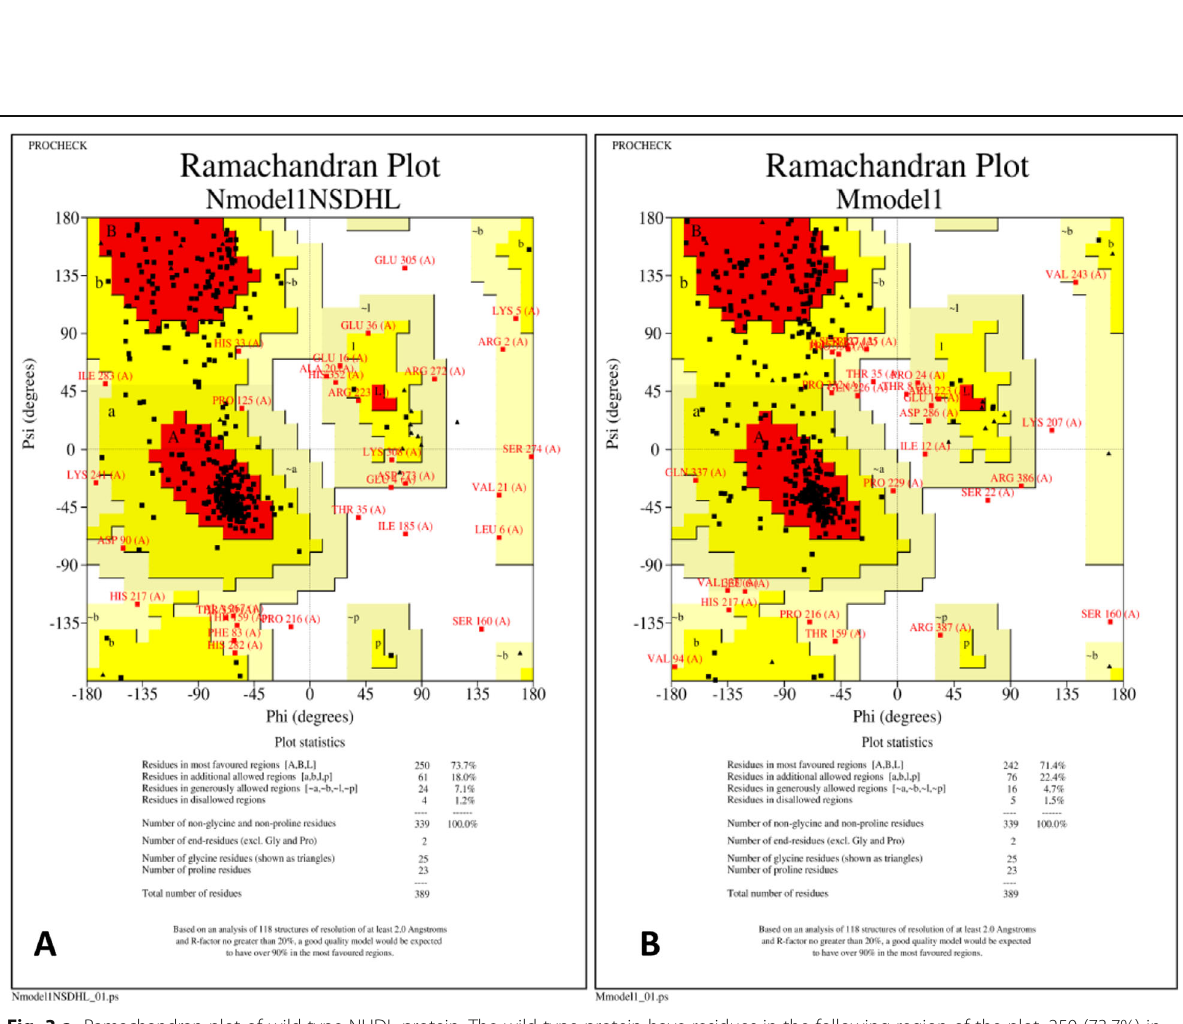
Fig. 3 a - Ramachandran plot of wild type NHDL protein; The wild type protein have residues in the following region of the plot, 250 (73.7%) in the preferred regions such as A, B, L; 61 (18.0%) in a,b,l,p regions; 24 (7.1%) in regions ~a,~b,~l,~p and only 4 (1.2%) in unfavorable regions. b - Ramachandran plot of mutant NHDL protein; In the mutant proteins we observed 242 (71.4%) in A, B, L; 76 (22.4%) in a,b,l,p regions; 16 (4.7%) in regions ~a,~b,~l,~p and 5 (1.5%)) in unfavorable regions